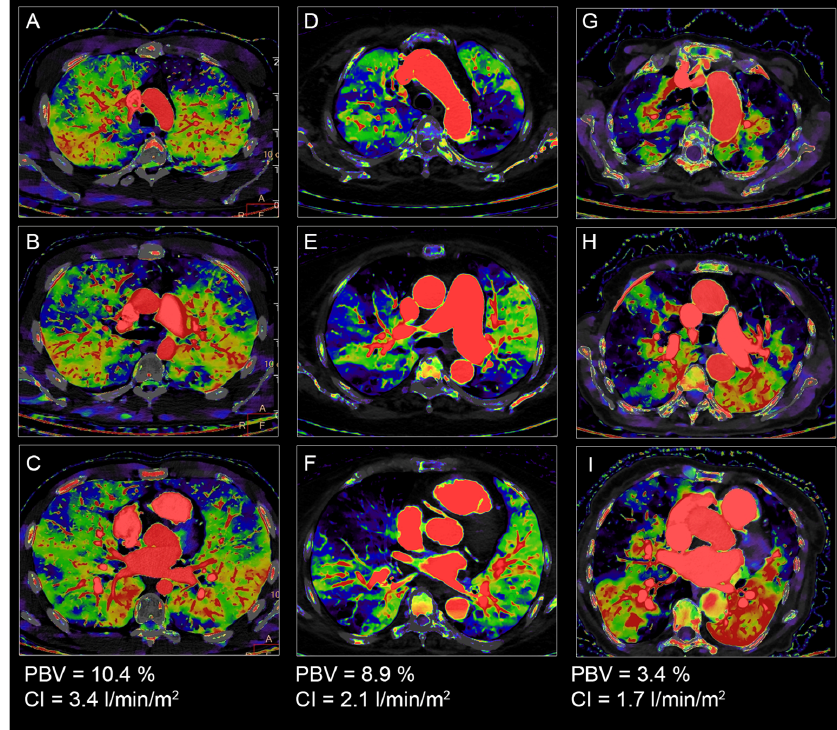
Figure 5. Cases of chronic thromboembolic pulmonary hypertension patients. ( A – C ).